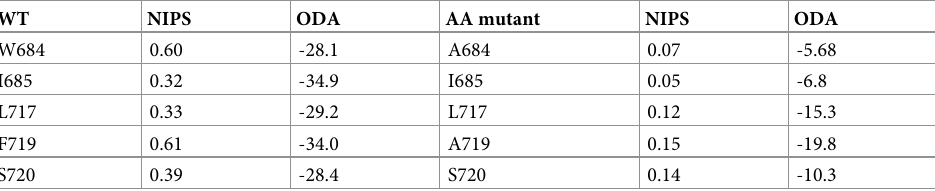
Table 1. Core residues of TLR2 TIR domain critical for TLR2-VCL interaction. WT NIPS ODA AA mutant NIPS ODA W684 0.60 -28.1 A684 0.07 -5.68 I685 0.32 -34.9 I685 0.05 -6.8 L717 0.33 -29.2 L717 0.12 -15.3 F719 0.61 -34.0 A719 0.15 -19.8 S720 0.39 -28.4 S720 0.14 -10.3 ODA and NIPS values for WT and W684A/F719A double mutant of core protein-protein residues of TLR2-VCL